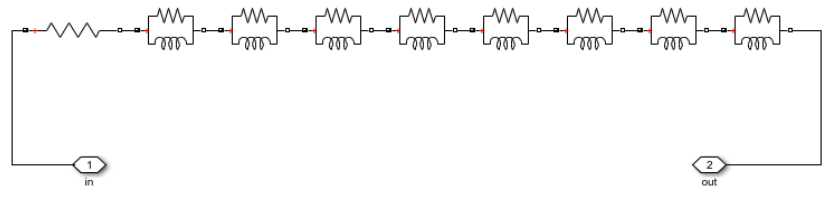
Figure A1. The content packaged in module “L α ”.